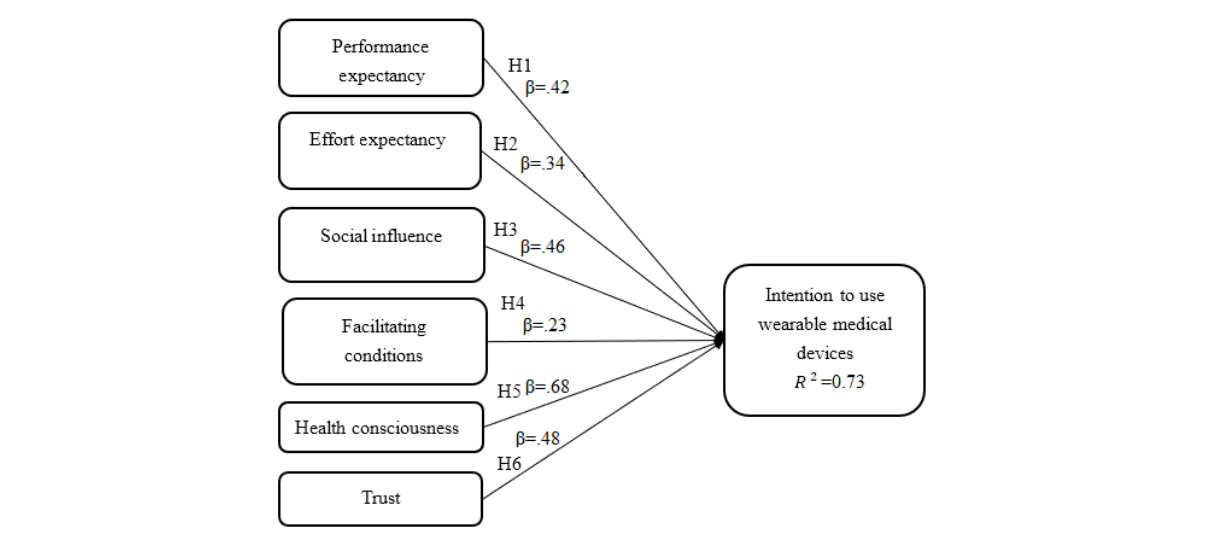
Figure 2. Results of the testing model. For all values, P